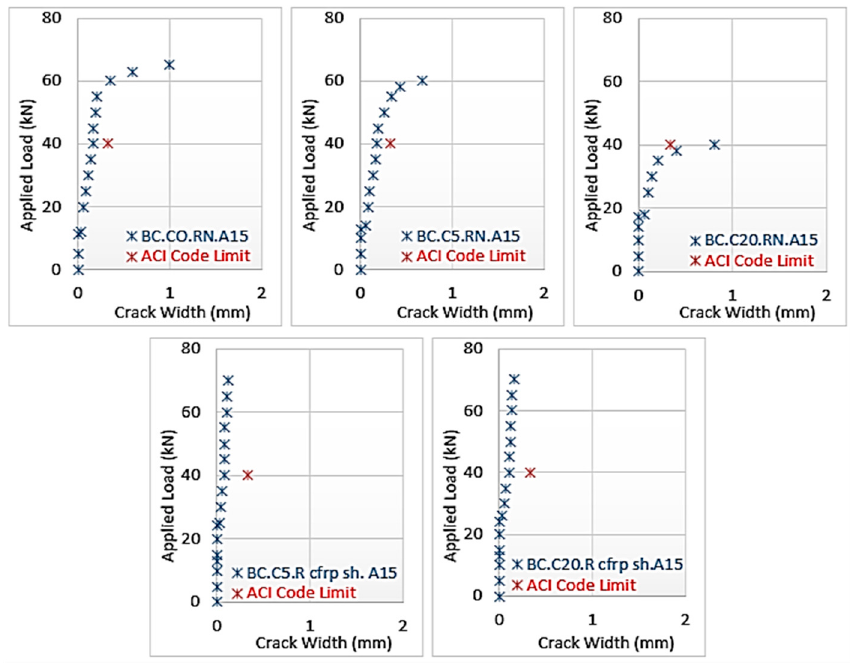
Figure 8. Maximum crack width for specimens in group A.